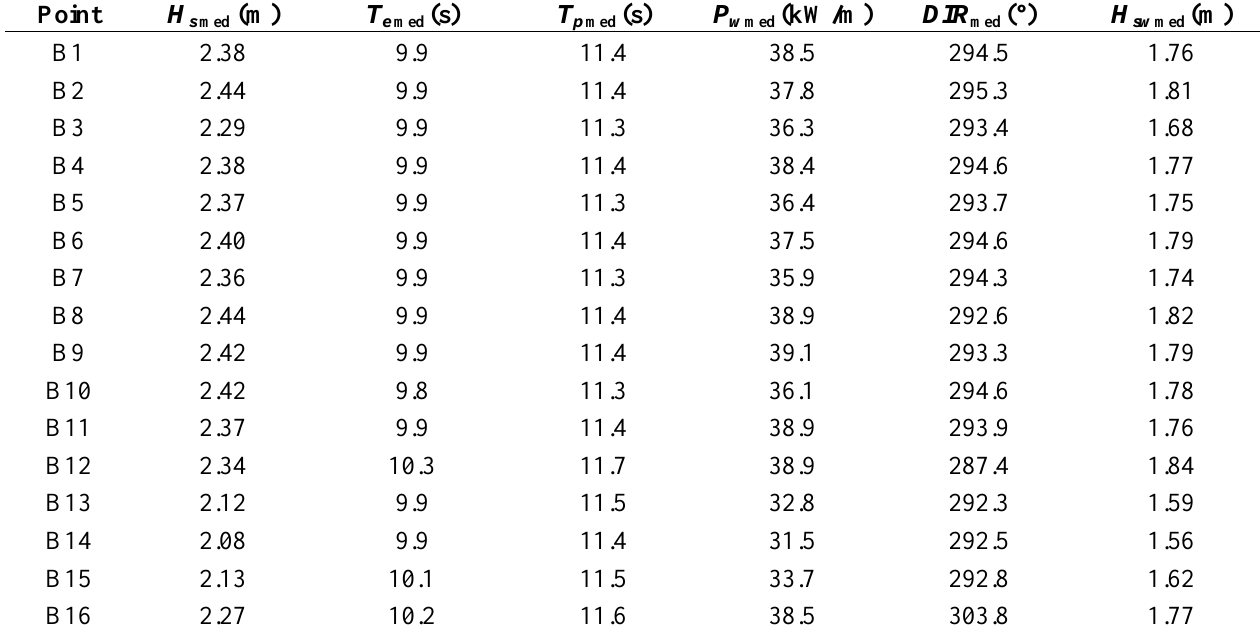
Table 4. Average values for the main wave parameters in the reference points from the central computational domain (B-points) as resulting from the simulations performed in the three-year period 2009–2011 (only for winter